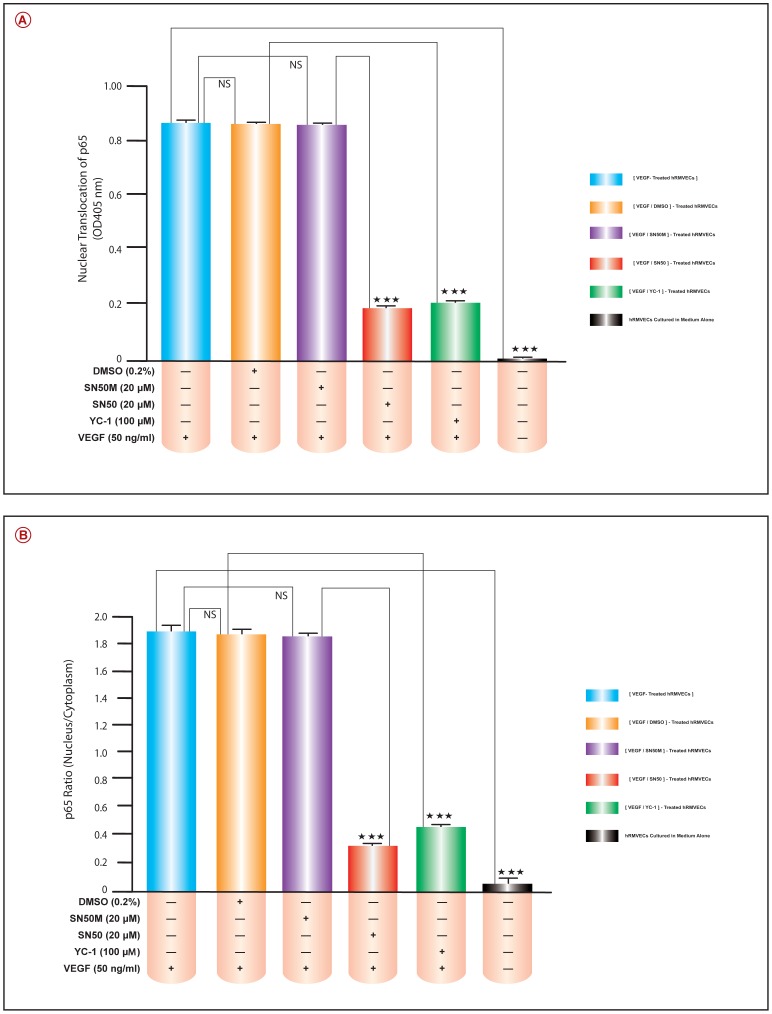
YC-1 Induced Specific Alterations in the Cytoplasmic-Nuclear Shuttling of NFκB/p65. A. ELISA Assay Analysis: YC-1 Inhibits Nuclear Translocation of NFκB/p65.The relative nuclear translocation of NFκB/p65 in hRMVECs was measured by ELISA. ELISA was performed as described in Materials and methods. NFκB/p65 translocation to the nucleus was inhibited in YC-1- and SN50-treated cells. Data are expressed as Mean ± SD of triplicate cultures from at least three independent experiments. B. The Relative Ratio of Nuclear to Cytoplasmic p65 in the Cells Treated with YC-1. Data represent the mean ± SD of three [3] independent experiments. Statistical analysis was performed [*P<0.05; **P<0.01; ***P<0.001, as compared with the DMSO-treated cells by Student’s two-tailed t-test].